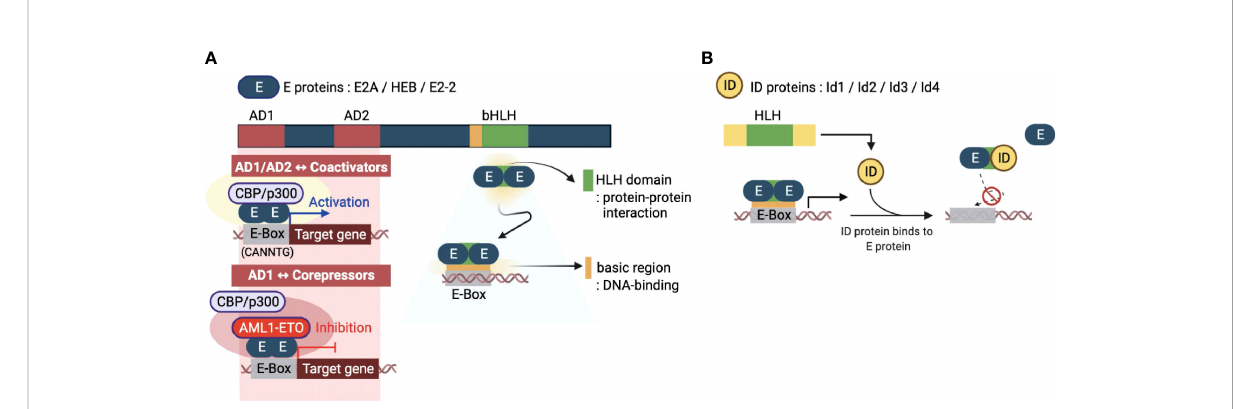
FIGURE 1 Molecular basis of E and ID protein functions. (A) An overview of the key domains of E proteins (E2A, HEB, and E2-2) - transcriptional activation domains (AD1 and AD2) and basic helix-loop-helix domain (bHLH). The AD1 and AD2 domains enable the E-box sequence (CANNTG) bound E protein homodimerization. E proteins function as transcriptional activators or repressors through recruitment of coactivators (CBP/p300) or corepressors (AML1-ETO, acute myeloid leukemia1-eight-twenty one oncoprotein), respectively. The bHLH domain consists of two parts: the HLH domain for protein-protein interactions and the basic region for DNA binding. (B) The four inhibitors of DNA binding (ID) proteins have one HLH domain in common. The ID protein interferes with the homo- or heterodimerized E proteins through this domain, inhibiting their DNA binding and transcription-related activities. This fi gure was created with